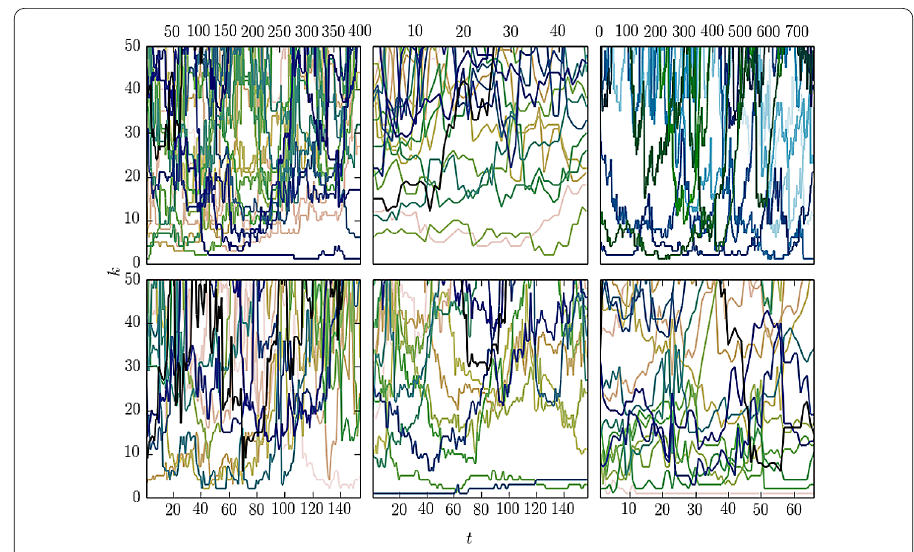
Figure 2 Temporal evolution of player and team rankings. Plot showing the change in rank k across time t of all players/teams in each sport and game considered in this study: ATP, FIDE, OWGR, FIFA, FCWR, and GPI (clockwise, starting from upper left corner). For clarity, only some of the first 50 ranks (at all available time slices) are shown. Notice that players/teams in lower ranks tend to change less than in higher ones, even when rankings across activities change at varying rates and the associated time resolution moves from weeks to months (see Table